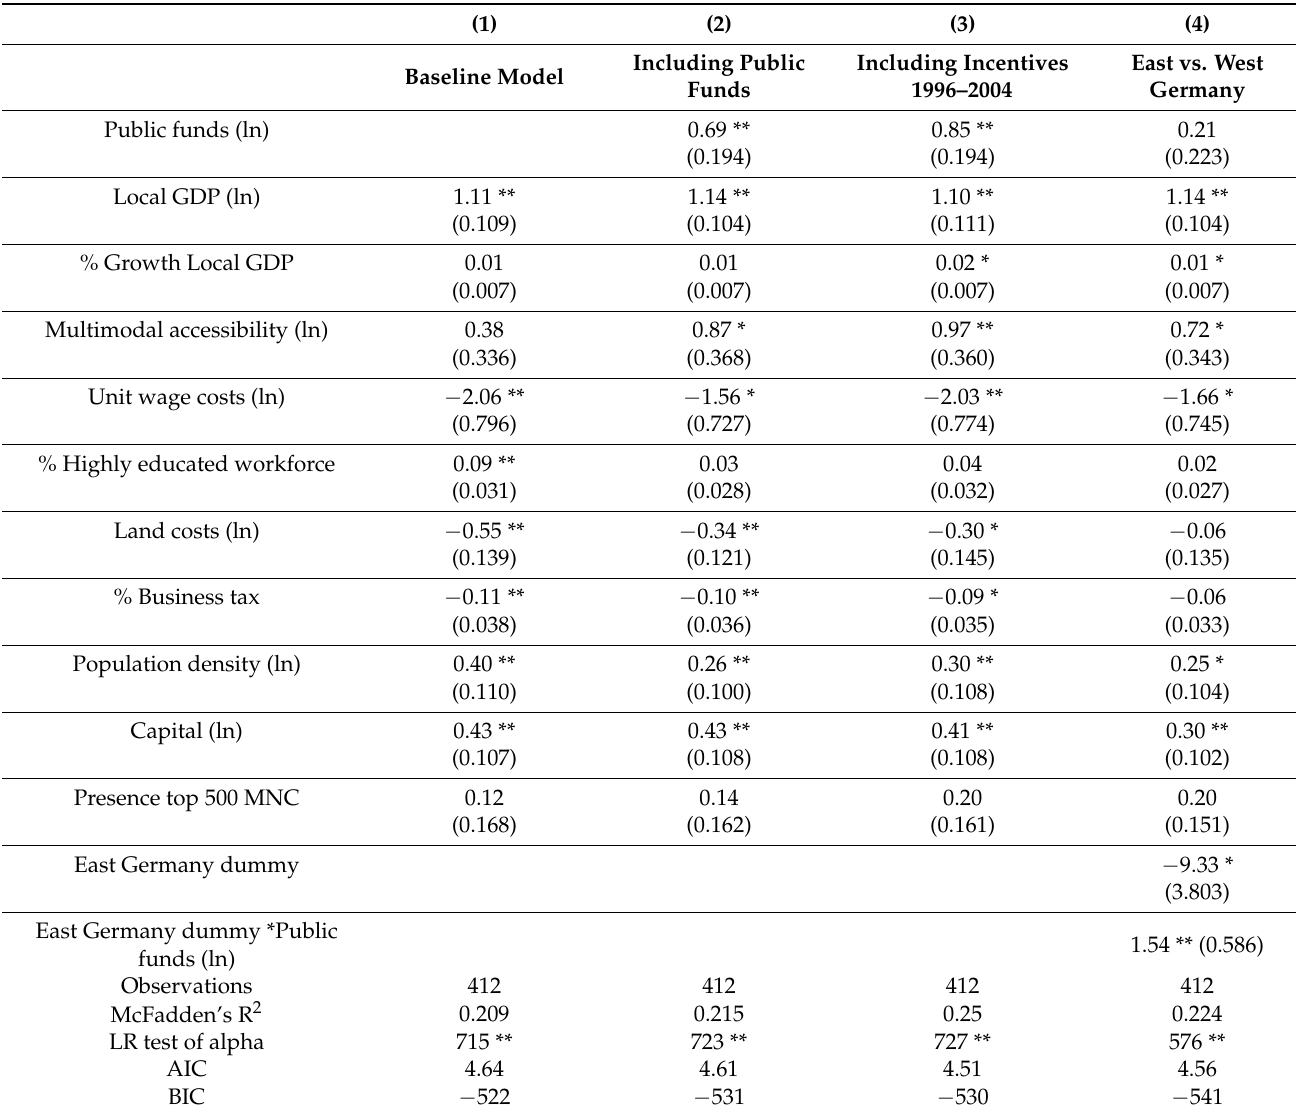
Table 4. Negative Binomial Estimations on Number of Greenfield